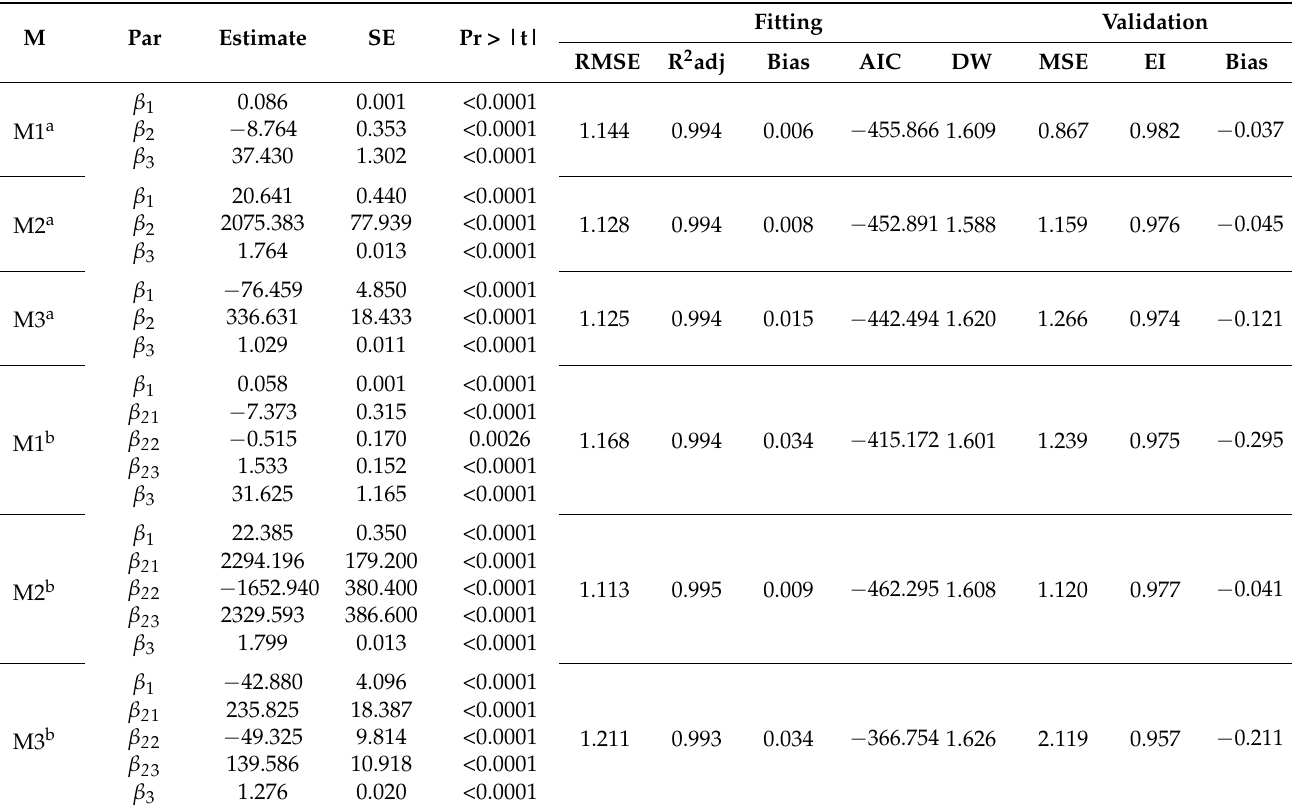
Table 4. Goodness-of-fit statistics of the dynamic equations for dominant height with and without the addition of topographic and climatic